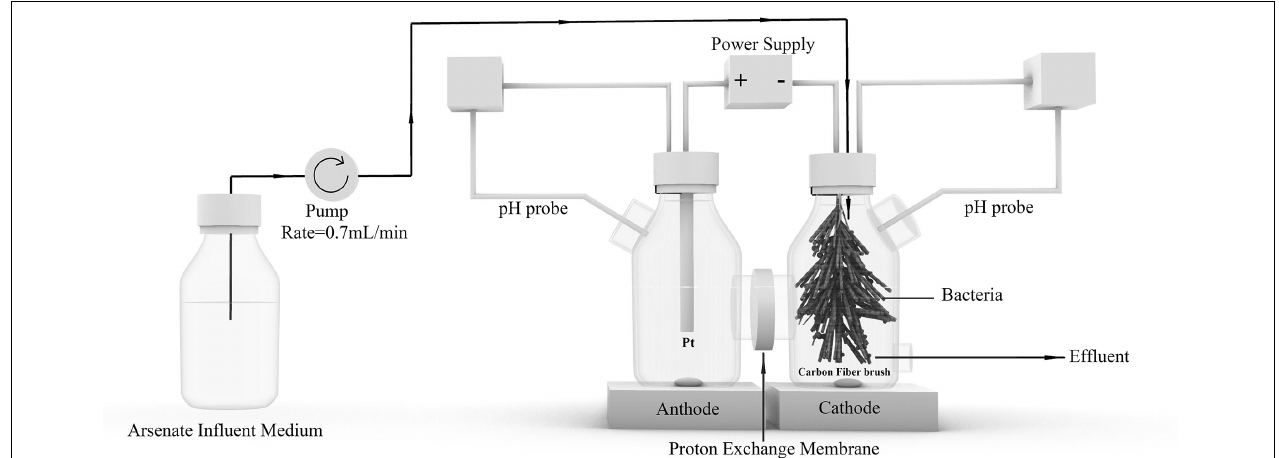
FIGURE 1 | Schematic diagram of the BES for arsenate removal from groundwater.